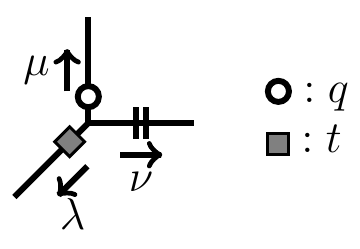
Figure 26 . A vertex whose three legs are labeled by a pair of ( t; (cid:21) ), ( q; (cid:22) ) and (cid:23) with the preferred direction. The preferred direction is denoted by jj